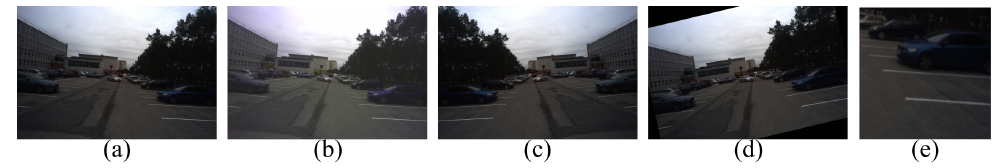
Figure 4. Data augmentation processes: ( a ) is the original image, ( b ) is color jitter, ( c ) is horizontal flip, ( d ) is random rotate in the range ( − 20 ◦ , 20 ◦ ), ( e ) is the random crop of dimension 128 ×